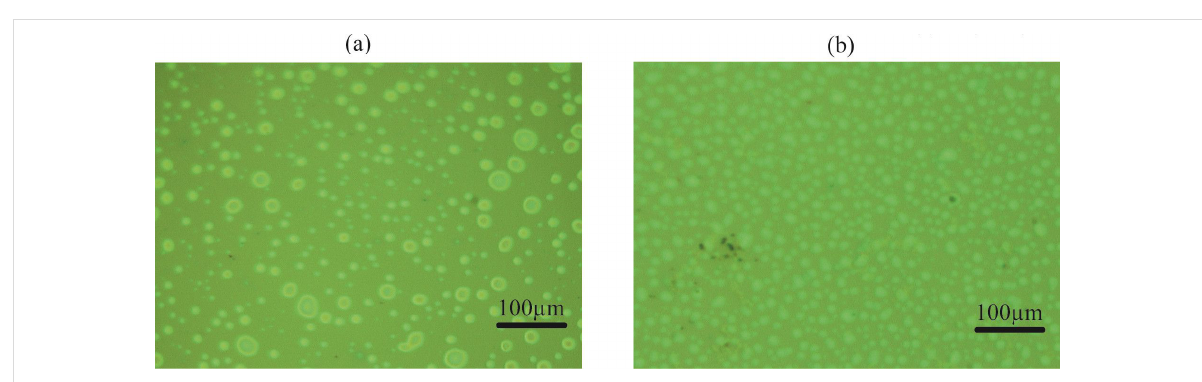
Figure 11: Optical images of blisters formed on a PS-coated surface immersed in (a) DI water and (b) ethanol.